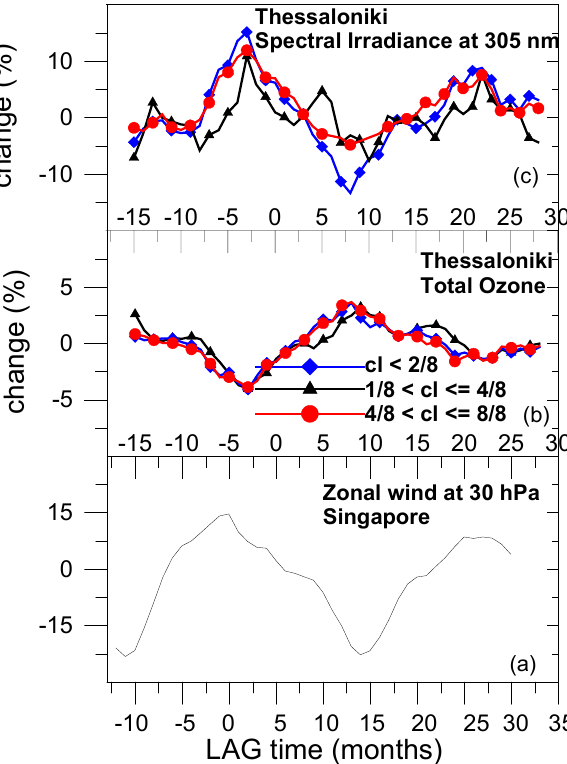
Fig. 2. Composites of (a) 30 hPa zonal wind at Singapore, (b) total ozone at Thessaloniki, and (c) solar irradiance at 305 nm. The com- posites have been calculated for the last four QBO cycles (1990– 1997) and measurements correspond to all-sky conditions and a so- lar zenith angle of 63 ◦